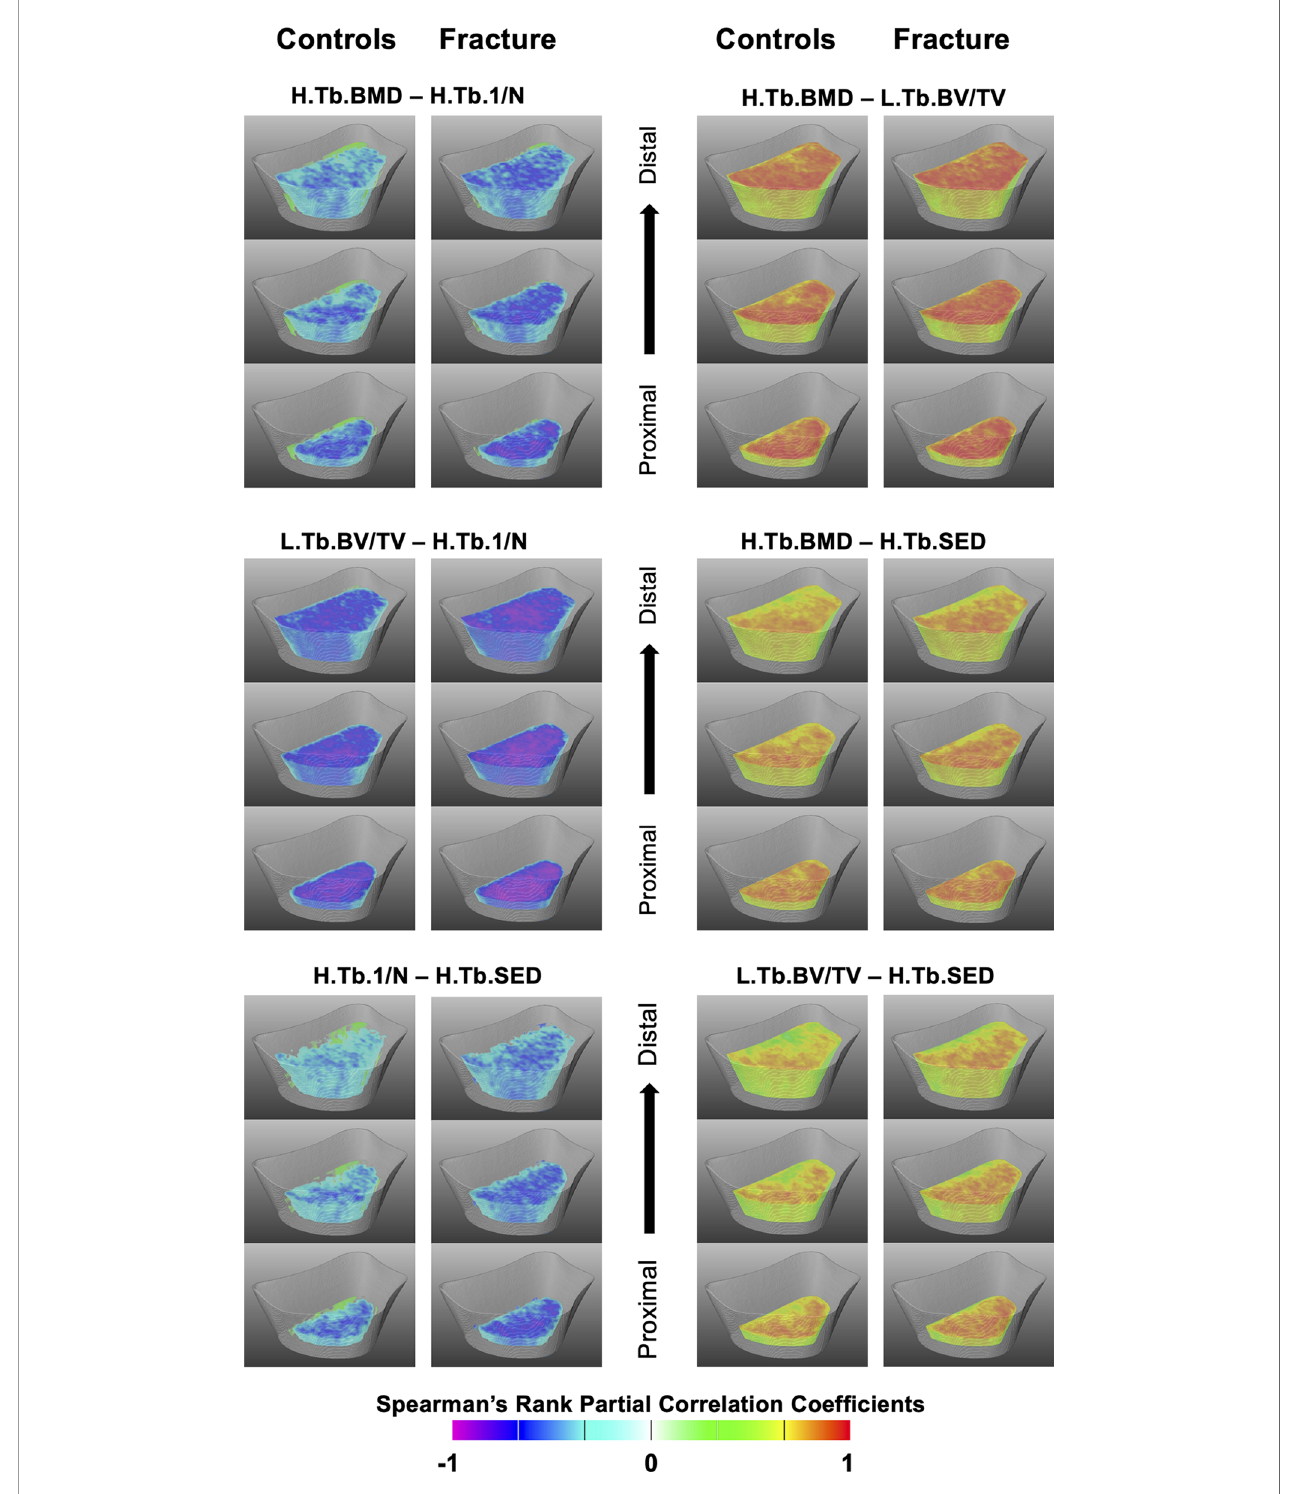
FIGURE 3 | Spatial assessment of interrelationships of trabecular bone parameters. Three-dimensional views at three different levels (1/4, ½ and ¾ of the scan length) of the statistical maps showing Spearman ’ s rank partial correlation coef fi cients for the different interrelationships of trabecular bone parameters for controls and fracture cases. All maps were adjusted for age, height, weight, and shape. Voxels that were no signi fi cant after correcting for multiple comparisons were rendered